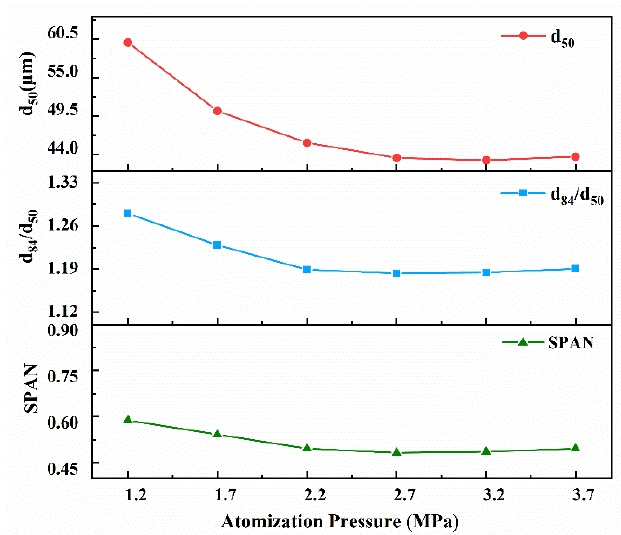
Figure 15. The e ff ect of operating pressure on d 50 , d 84 / d 50 and SPAN for the KHRT breakup Figure 15. The effect of operating pressure on d 50 , d 84 /d 50 and SPAN for the KHRT breakup model model simulation. simulation.